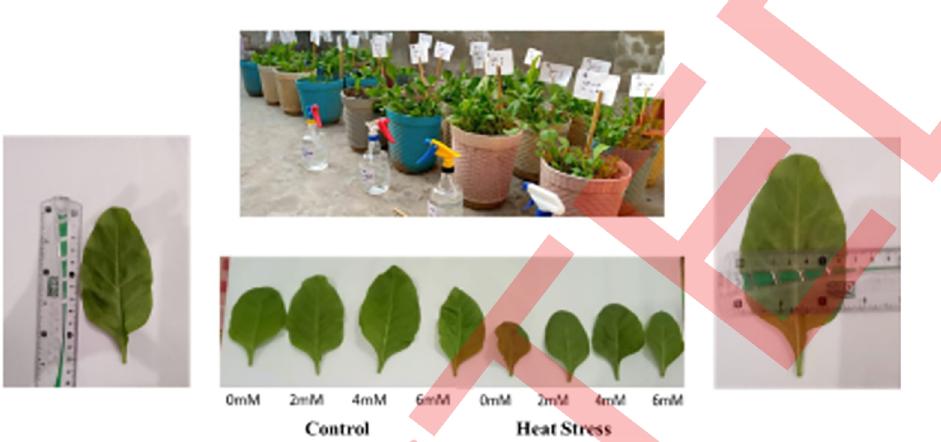
Fig 7. Pictorial view of various management and data collection activities during the course of the study.